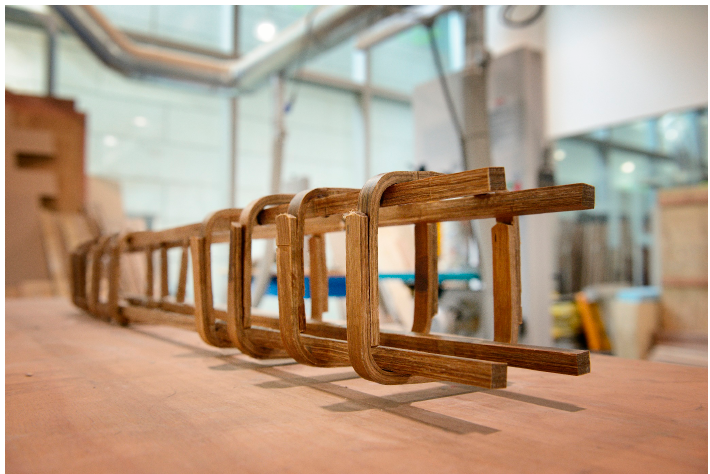
Figure 6. Bamboo composite reinforcement system.